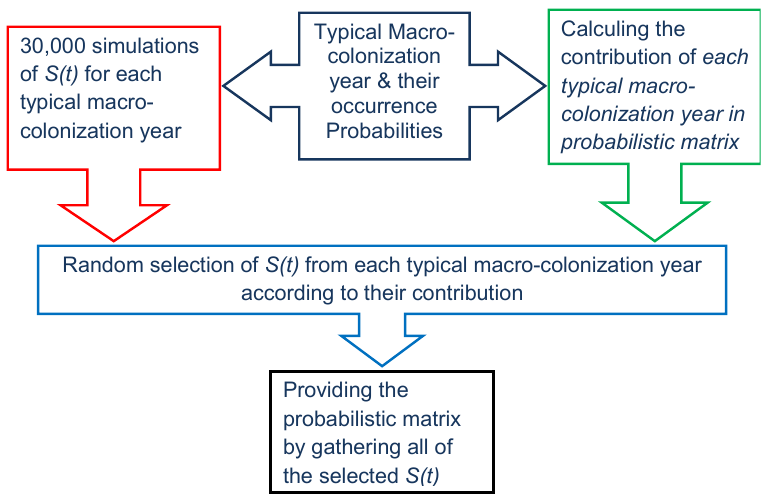
Figure 13. Schematic procedure of probabilistic individual shell length time-series from the typical macro-colonization year.